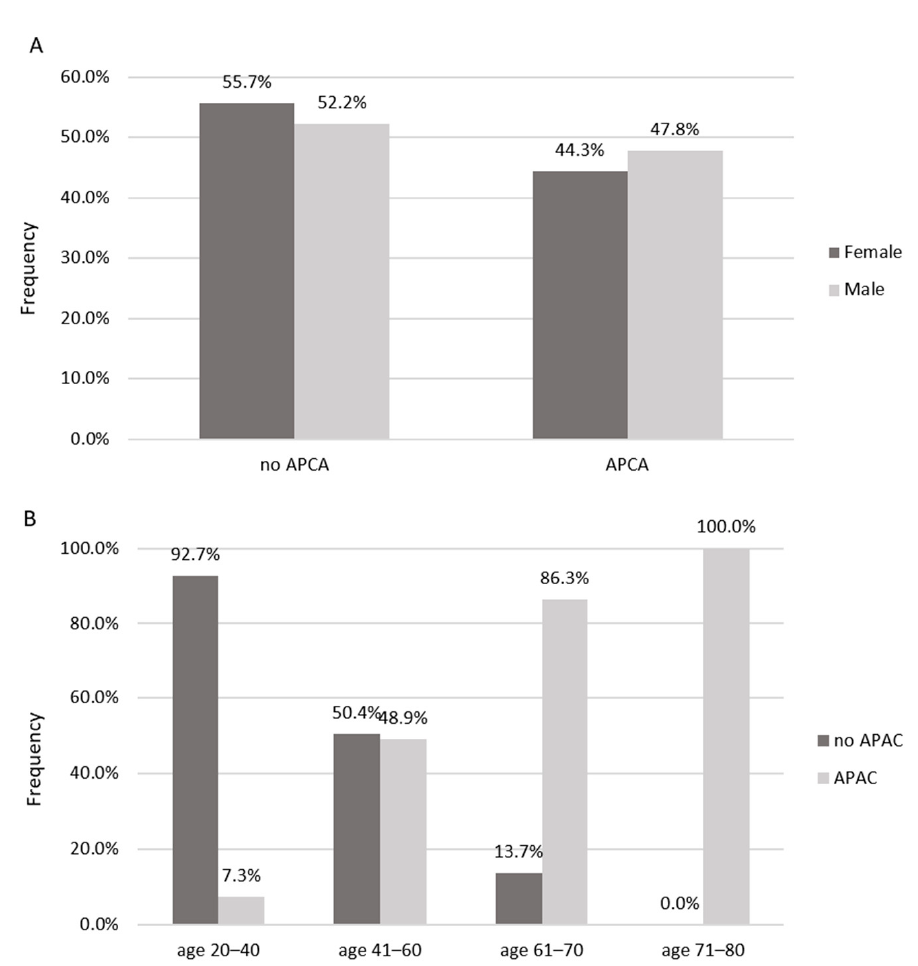
Figure 1. Prevalence of atherosclerotic plaques in carotid arteries by gender ( A ) and age groups ( B ). Table 2. Characteristics of the study group depending on the presence of atherosclerotic plaques in carotid arteries (APCA).